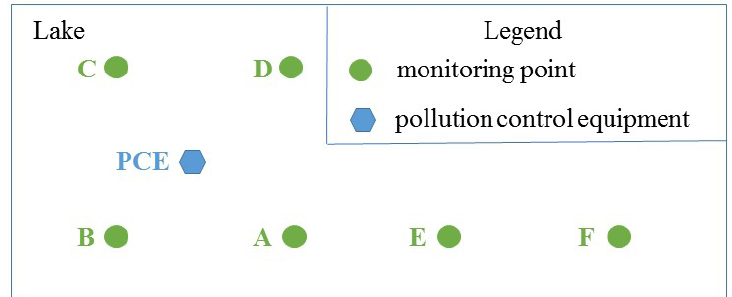
Figure 23. Sketch map of lake water